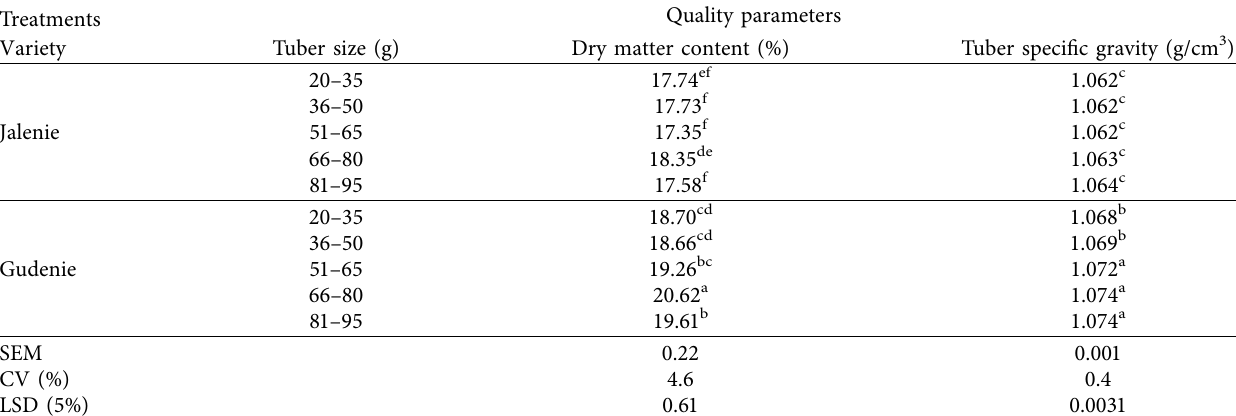
Table 9: Interaction effects of variety and tuber size on quality parameters of potato in 2013/2014 at Nono Benja. Treatments